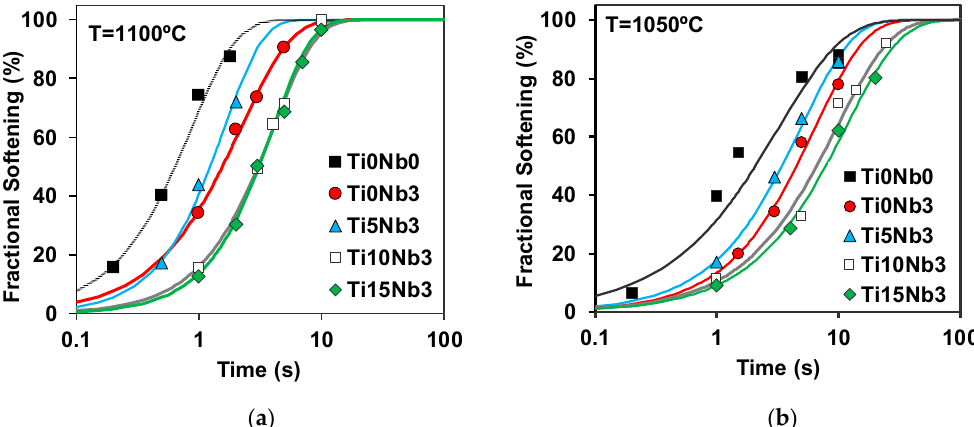
Figure 8. Effect of steel composition on the softening curves at high temperatures, roughing pass applied, 𝜀 = 0.35, 𝜀(cid:4662) = 1 s − 1 . ( a ) T = 1100 °C, ( b ) 1050 °C. applied, ε = 0.35, . ε = 1 s − 1 . ( a ) T = 1100 ◦ C, ( b ) 1050 ◦ C.